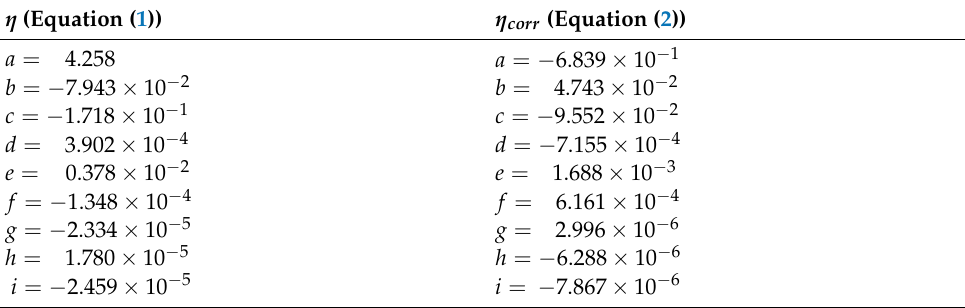
Table 2. Values of correlation coefficients for Equations (1) and (2), which were applied to simulate the multi-ejector efficiency (developed for the range 4–6